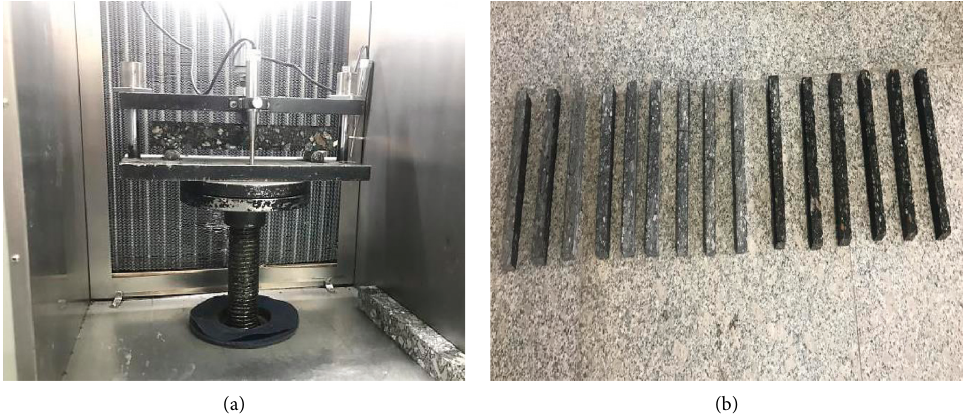
Figure 7: Asphalt mixture low-temperature bending test: (a) the equipment and (b) test sample.